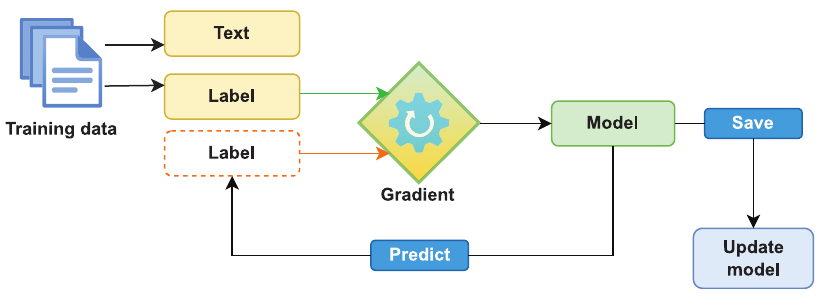
Figure 4. NER custom model training of